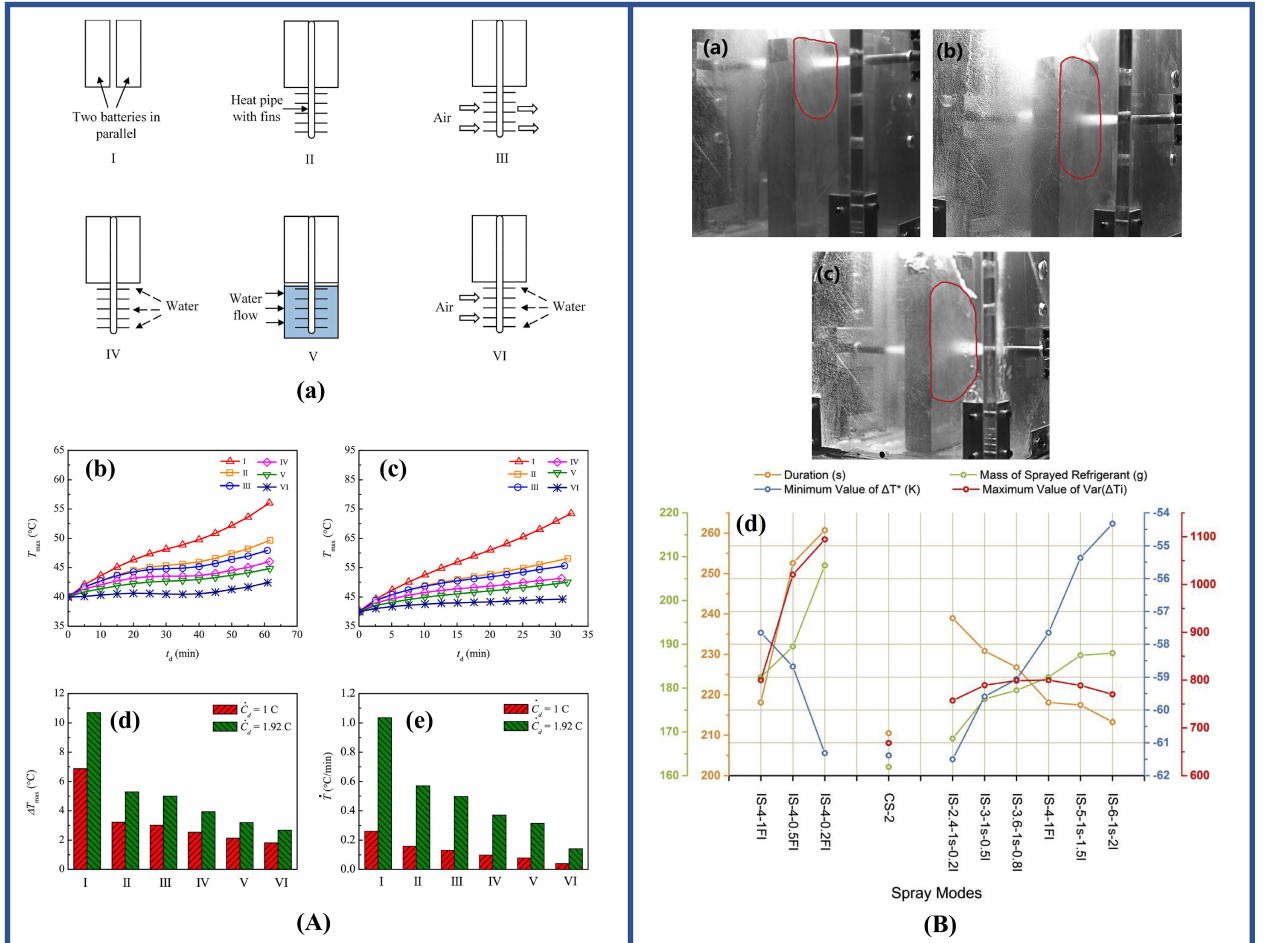
Figure 12. Research and analysis on spray cooling effect of power battery under conventional heat generation. ( A ): Cooling performance comparison of the six BTM schemes: I: BTM auxiliary tools; II: heat pipe without air flow; III: heat pipe and air circulation; IV: heat pipe, water spray but no air flow; V: Water flow and heat pipe; VI: heat pipe, water spray and air flow ( a ); comparison of battery thermal characteristics with six BTM schemes, the maximum surface temperature of the battery Cd = 1C at ( a ) and Cd = 1.92C ( b ); maximum temperature difference of the battery surface ( c ); the maximum temperature rises rate of the battery surface ( d ) the rates of the maximum temperature rise on the battery surfaces ( e ) [173]. ( B ): Figure of cooling medium coverage distribution at the spray positions in 3 ( a ) 2 ( b ) and 1 ( c ); duration under low oxygen condition, mass of refrigerant sprayed, minimum value of equivalent average temperature difference of unit mass of refrigerant, maximum value of variance of temperature difference of each temperature measuring point under different spraying mode when the actual spraying duration is 2 s ( d ) [171].